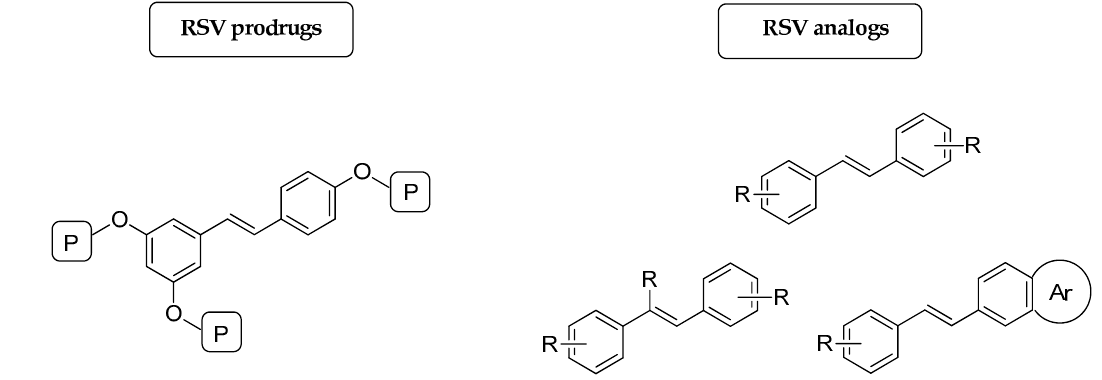
Figure 2. General structures of RSV prodrugs and RSV